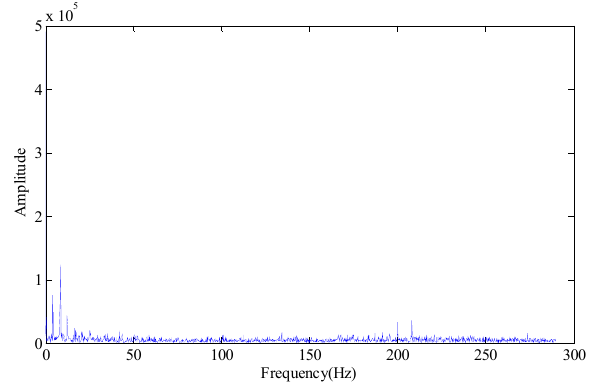
Figure 4. Envelope spectrum (singular values 1~4 set to 0).